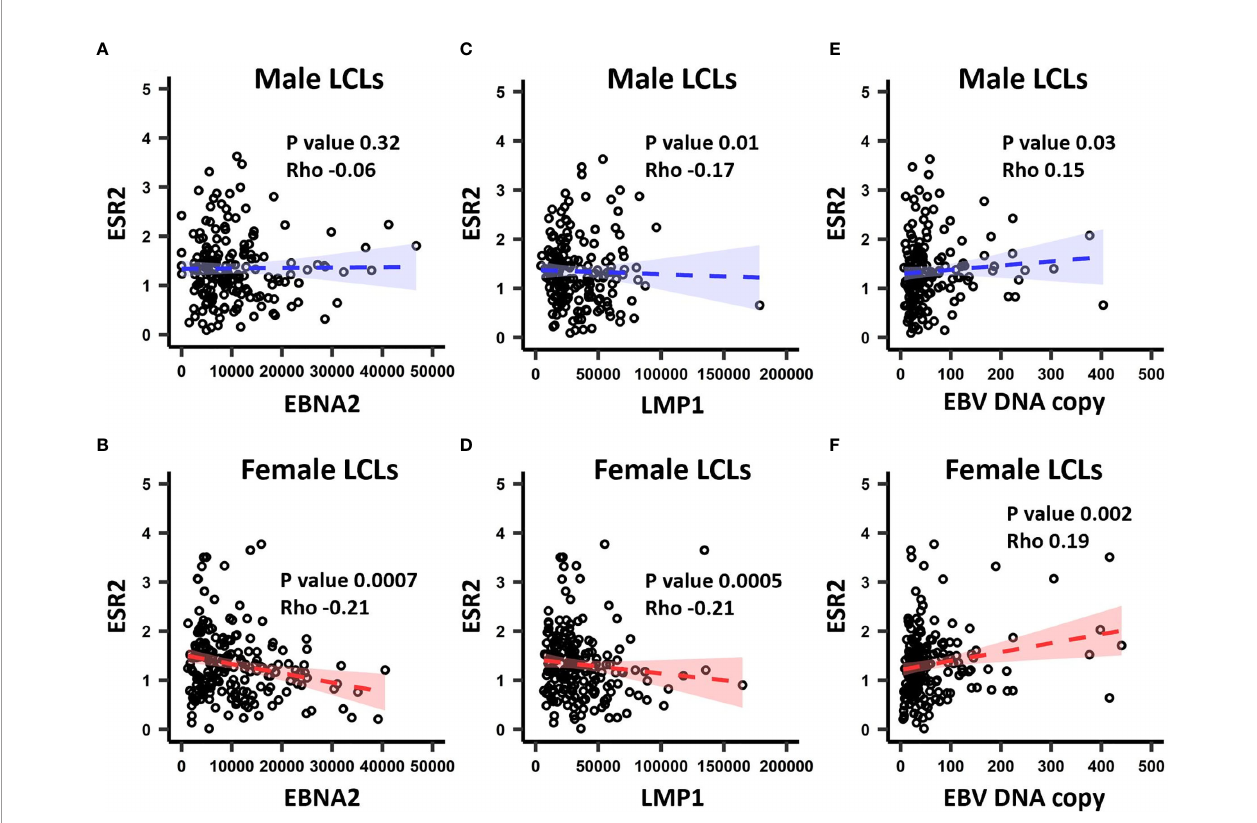
FIGURE 2 | The correlation between ESR2 expression level and EBV latency III traits. ESR2 correlation with EBNA2 in (A) males and (B) females. Correlation between ESR2 expression level and LMP1 expression level in males (C) and in (D) females. Correlation between ESR2 expression level and EBV DNA copy number in males (E) and in (F) females. The RNA-seq based expression levels for ESR2, EBNA2 and LMP1 were obtained from the GEUVADIS study and EBV Portal for 216 male LCLs and 248 female LCLs. The estimated EBV DNA copy number and ESR2 expression level for 201 male and 232 female LCLs were used to estimate the correlation between ESR2 and estimated EBV DNA copy number. The correlations were calculated using Spearman ’ s rank correlation coef fi cient for donor matched LCL